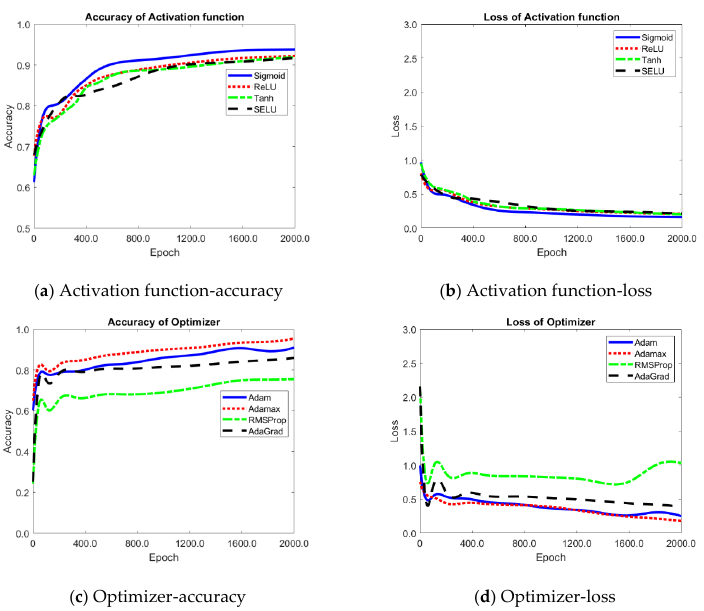
Figure 9. Performance test for the selection of the activation function and optimizer.